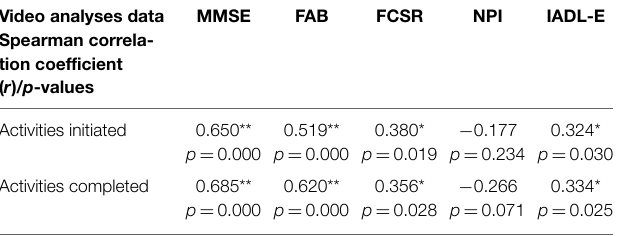
TABLE 4 | Correlation between IADL scenario performance and conven- tional cognitive assessments (Spearman’s correlation coefficient) . Video analyses data Spearman correla- tion coefficient ( r )/ p -values